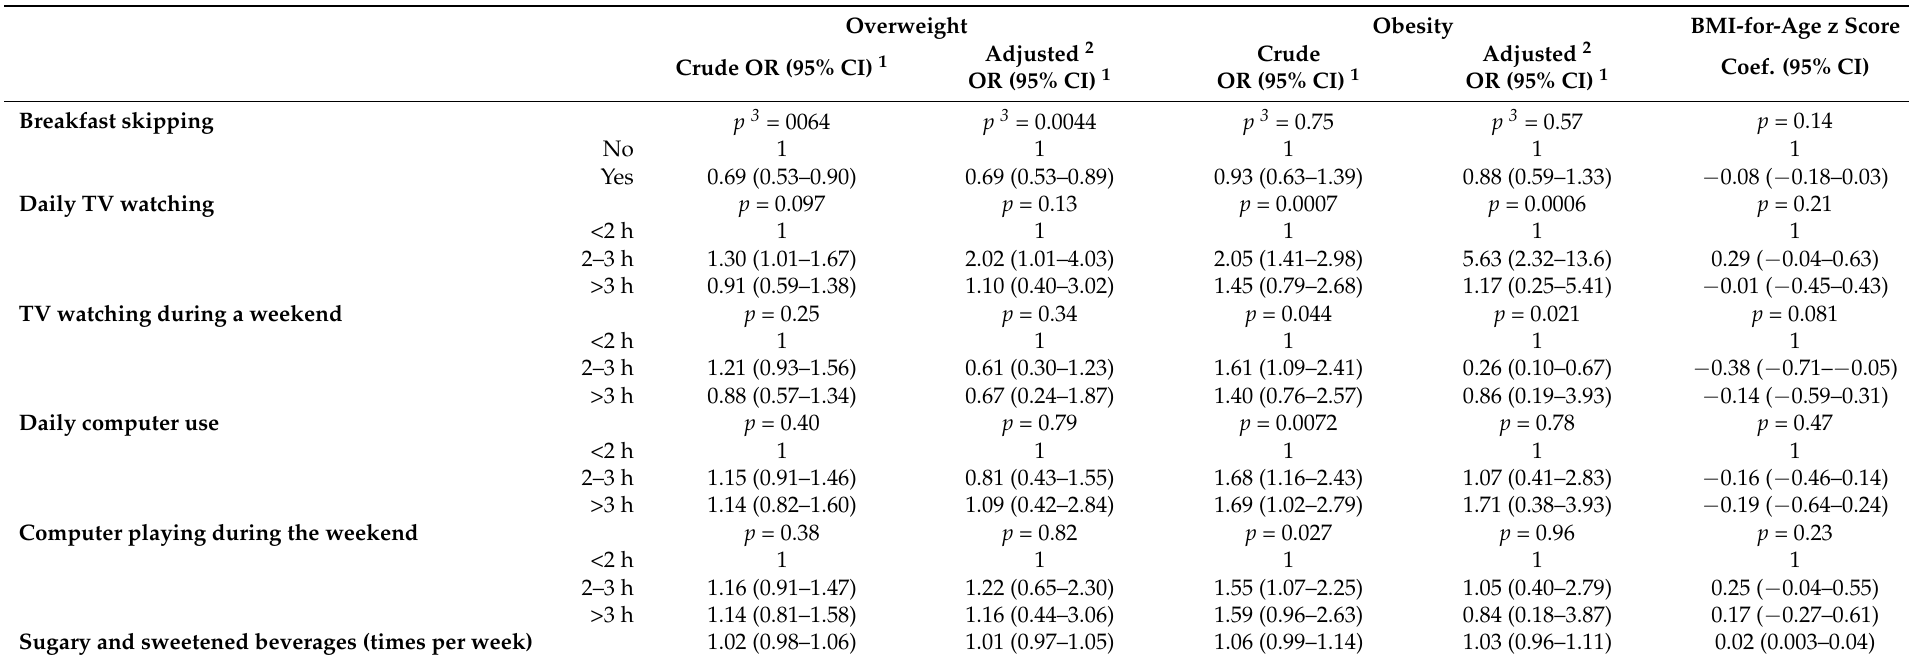
Table 4. Logistic regression for the association of overweight and obesity with breakfast skipping, screen time and sugary and sweetened beverage